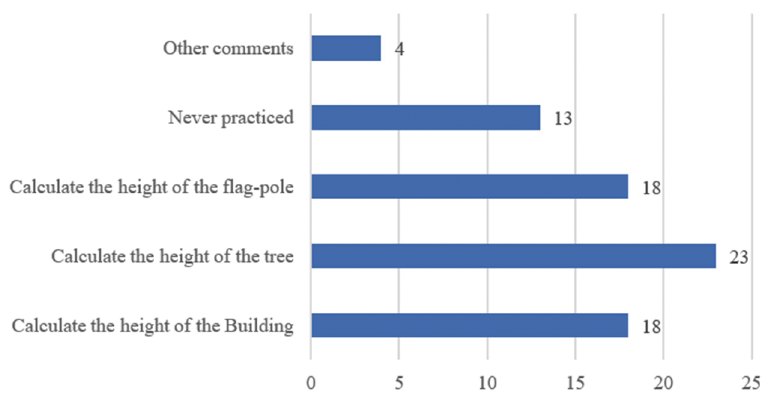
Figure 3. The practical content in the theme “Trigonometry ratio of an acute angle” is taught by the teacher to students